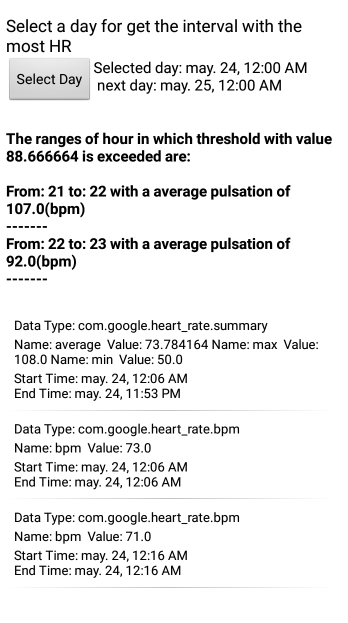
Figure 7. Screenshot of Android